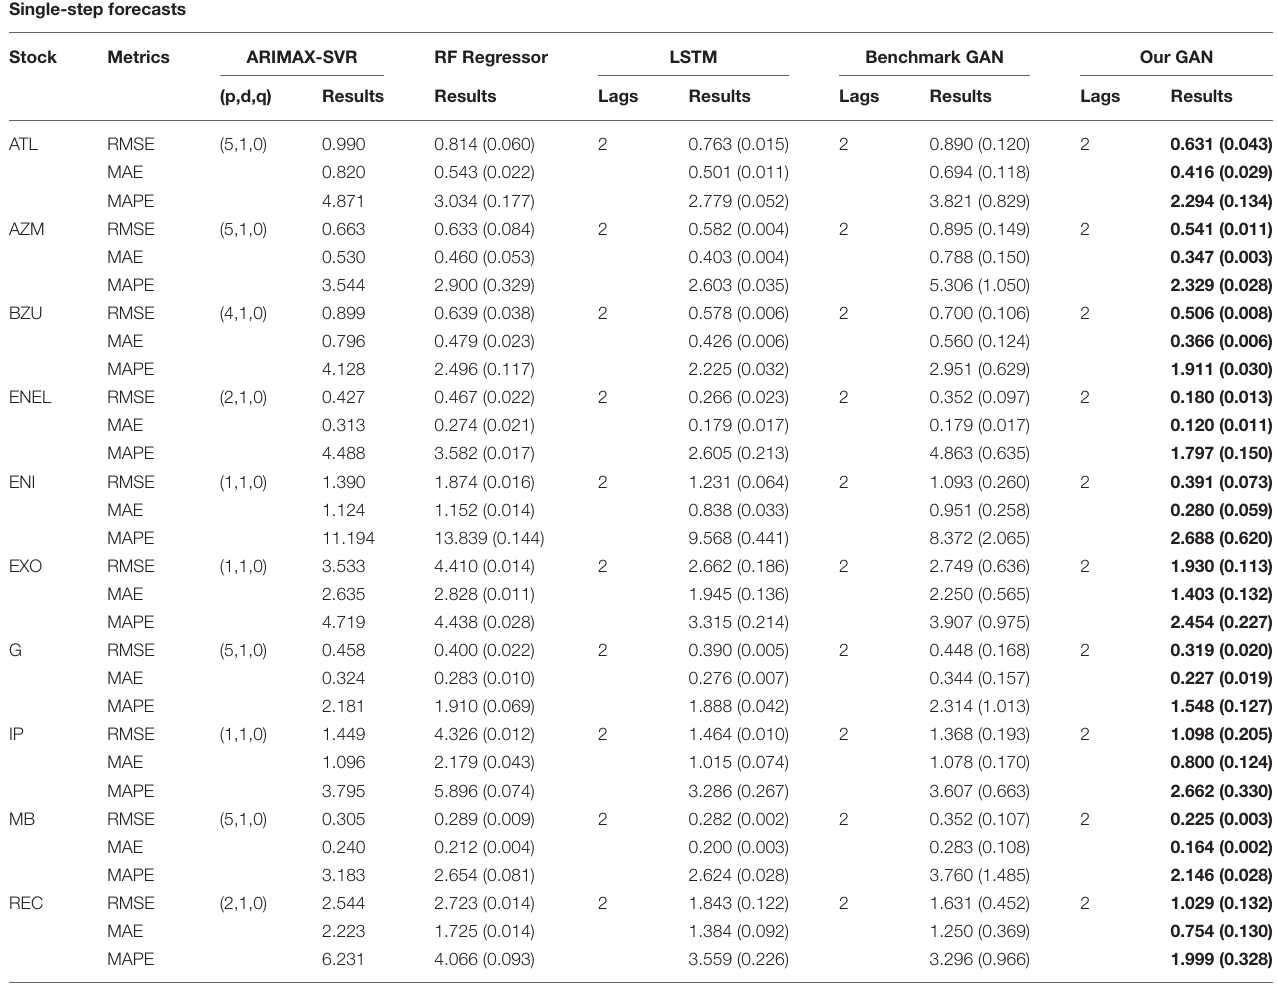
TABLE 3 | Single-step forecast errors for ARIMAX, RF Regressor, LSTM, the benchmark GAN, and our GAN architecture. Single-step